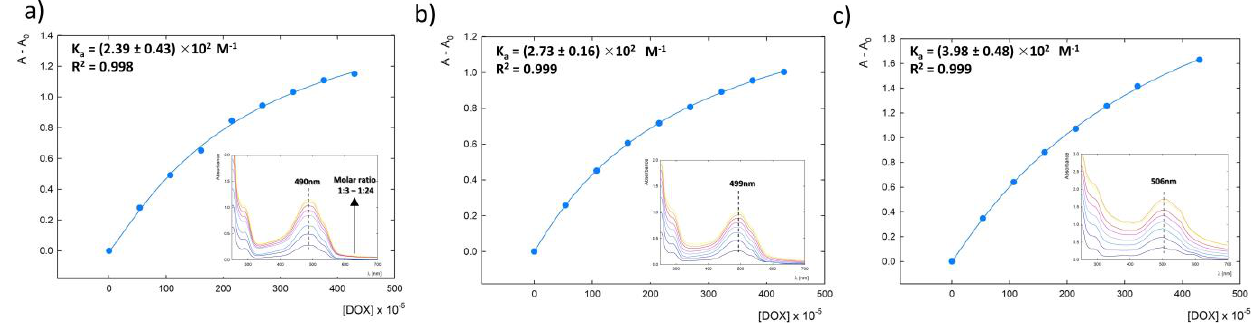
Figure 8. Relationship of A to c DOX for the G4.0 PAMAM-DOX complex for three pH values: ( a ) 9.0, ( b ) 9.5, and ( c ) 10.0.